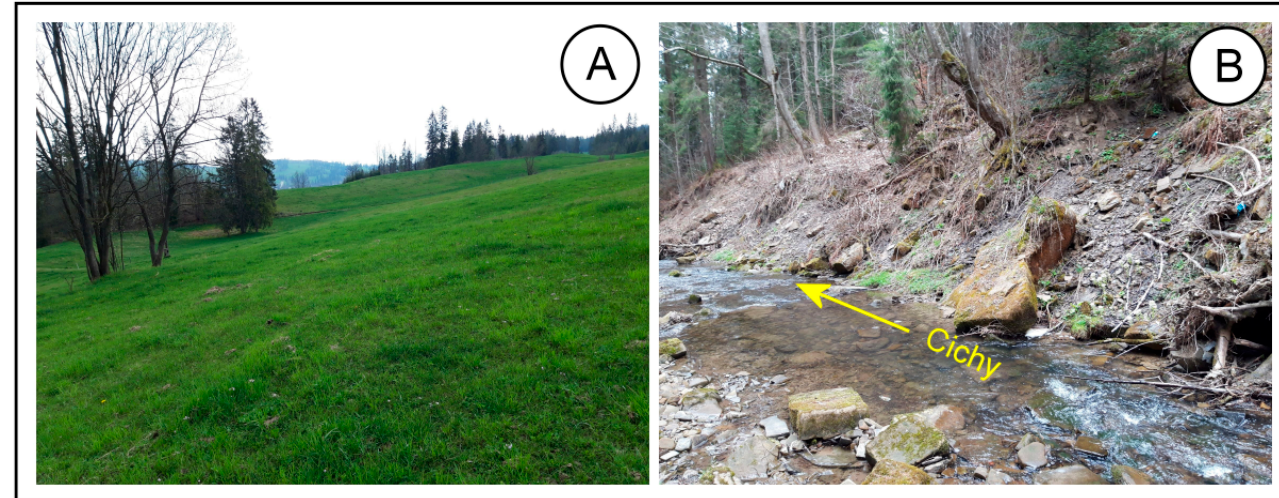
Figure 6. Grapa landslide (site 4); ( A )—colluvial ridges on the valley slope, ( B )—colluvial blocks in the channel of the Cichy River.